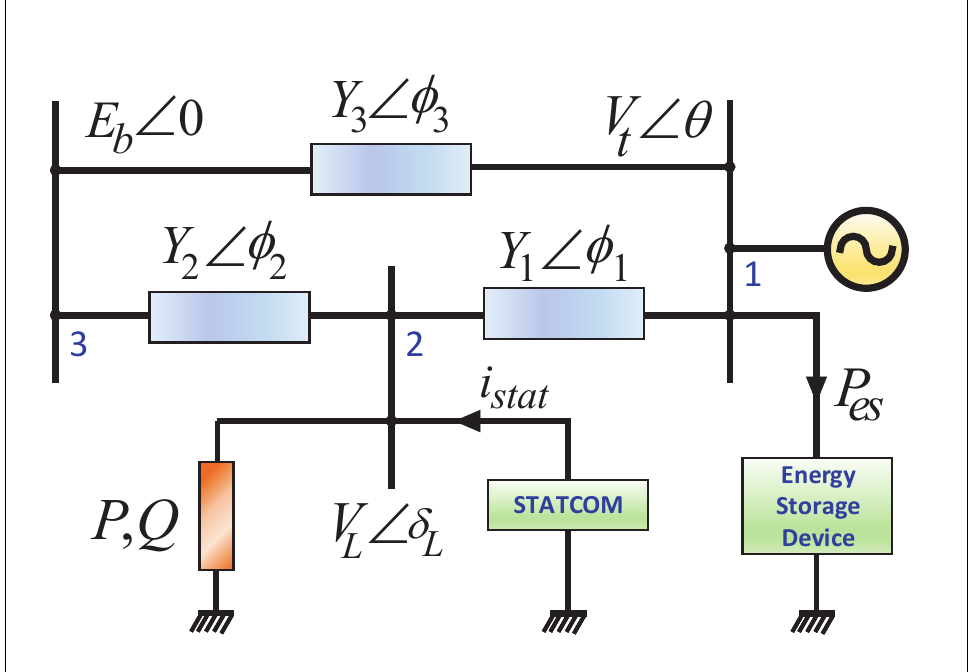
Figure 2. schematic diagram for the power system with the connecting locations of the energy storage device and the STATCOM